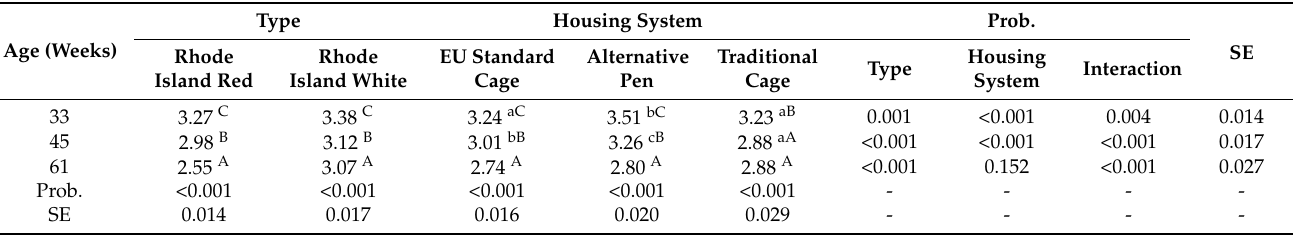
Table 5. Effect of type and housing system on the plumage score on the rectrices of non-beak-trimmed Rhode Island